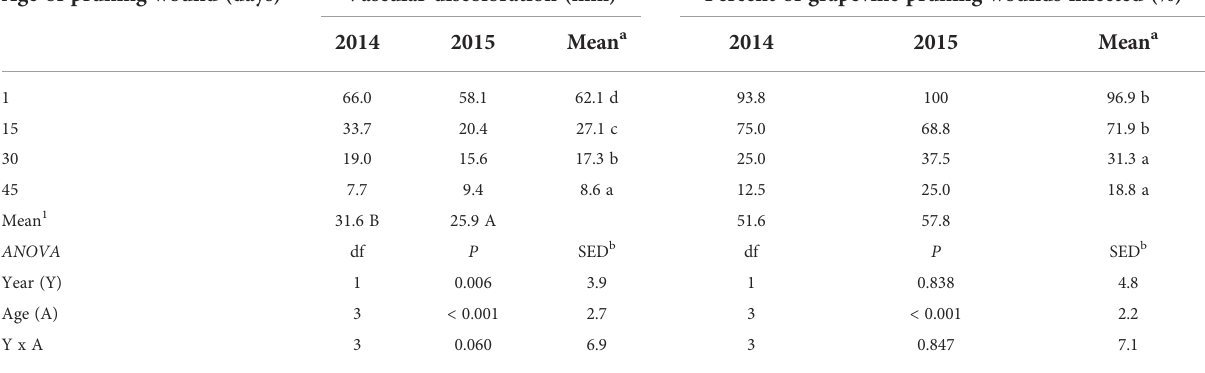
(Table 2; Figure 5). In 2015, inoculation of P. chlamydospora on fresh pruning wounds (one day of age of pruning wounds) produced signi fi cantly more extensive vascular discoloration, with values of 58.2 mm (Nancagua) and 49.1 mm (Buin), than the vascular discoloration obtained from spurs inoculated at 15, 30, and 45 days after pruning, with values of 34.4 mm (Nancagua) to 8.1 mm (Buin) (Figure 5).